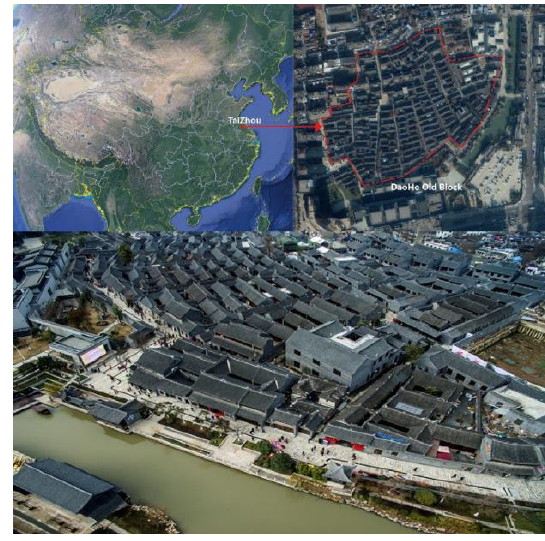
Figure 2. The location of the research site.